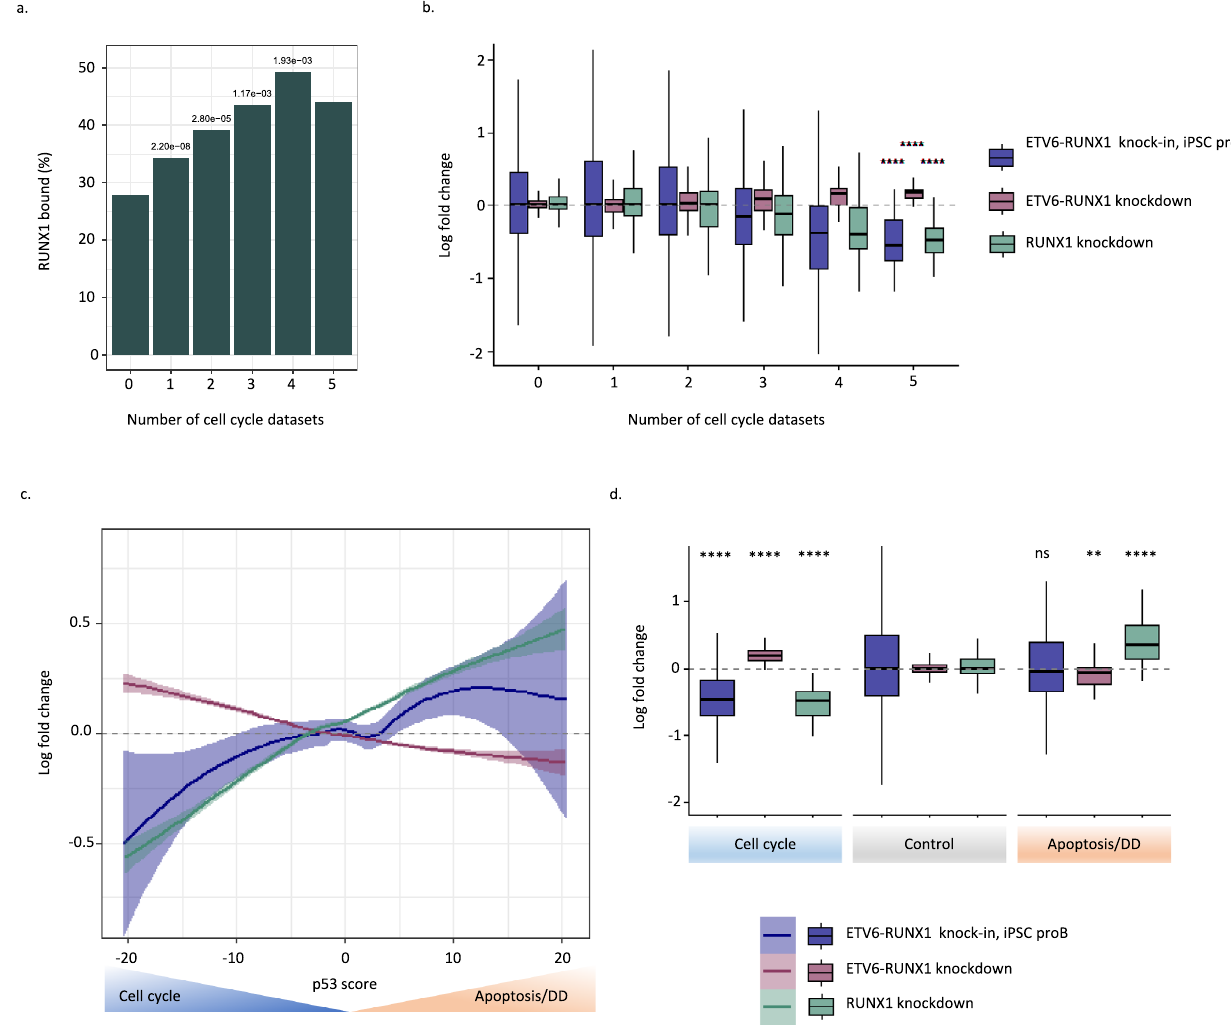
Fig.6|AbalancebetweenCBFcomplexandETV6-RUNX1ontheP53-regulated cell cycle-apoptosis axispromotes a silent pre-leukemic state. a , b Comparison of RUNX1 and ETV6-RUNX1 regulomes to cell cycle meta-analysis 42 . Genes ( n =19148) were binned according to the number of data sets in which they were de fi ned as cellcyclegenes.Barplotshowsthepercentageof genesassociated with aRUNX1bindingevent( a )whileboxplotsshowlogfoldchangefollowingRUNX1or ETV6-RUNX1 knockdown or in ETV6-RUNX1 knock-in iPSC-derived proB cells ( b ). c Plot of mean log fold change for genes binned according to their p53 score for ETV6-RUNX1-expressing ProB cells, ETV6-RUNX1 knockdown, RUNX1 knockdown, and CBFi (AI-14-91) treatment. Negative p53 scores are associated with cell cycle genes while positive scores are associated with direct p53 targets involved in